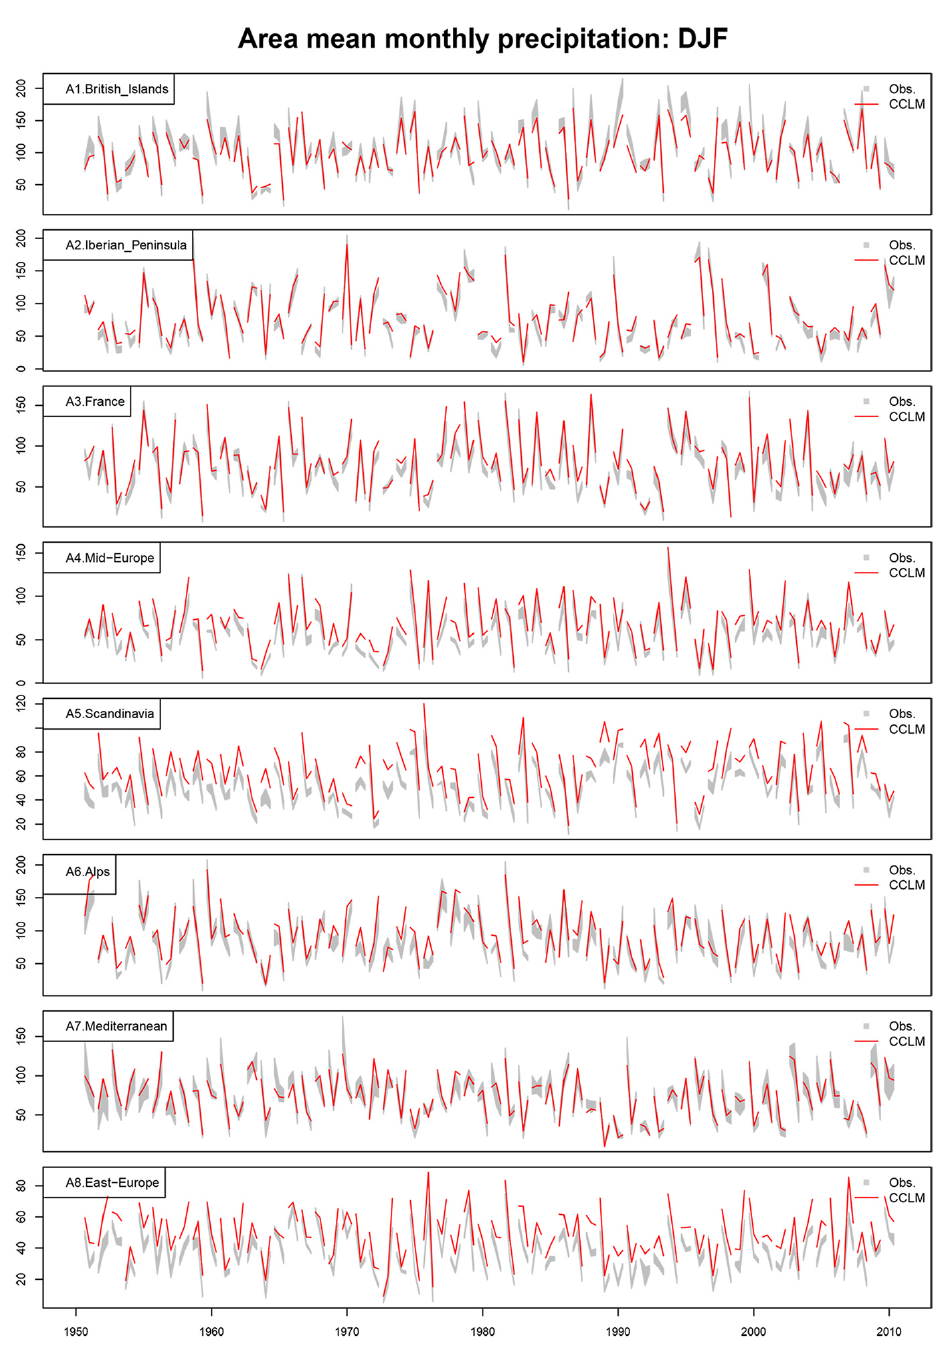
Figure 8a. Area mean monthly sums of total precipitation of December, January, and February of 1950–2010: coastDat2-CCLM (red), range of GPCC6, E-OBS8.0 and CRU3.2 for each season (gray